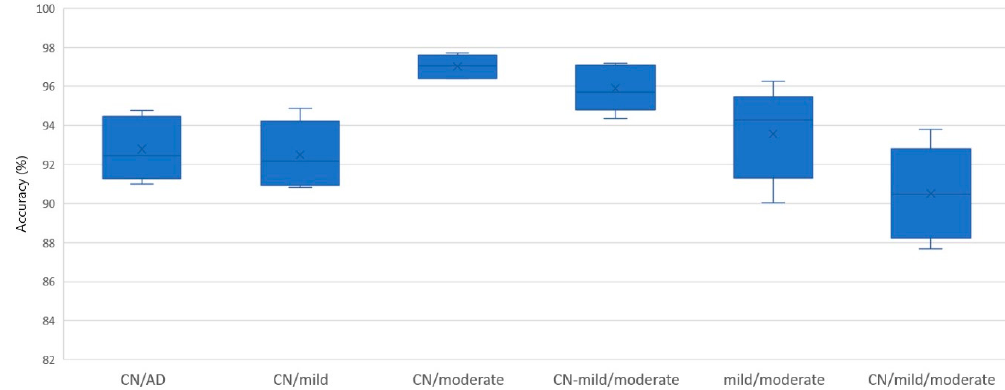
Figure 3. Boxplot of the accuracy results from all electrode clusters for each classification problem: The abbreviation CN stands for Controls and AD stands for Alzheimer’s Disease.